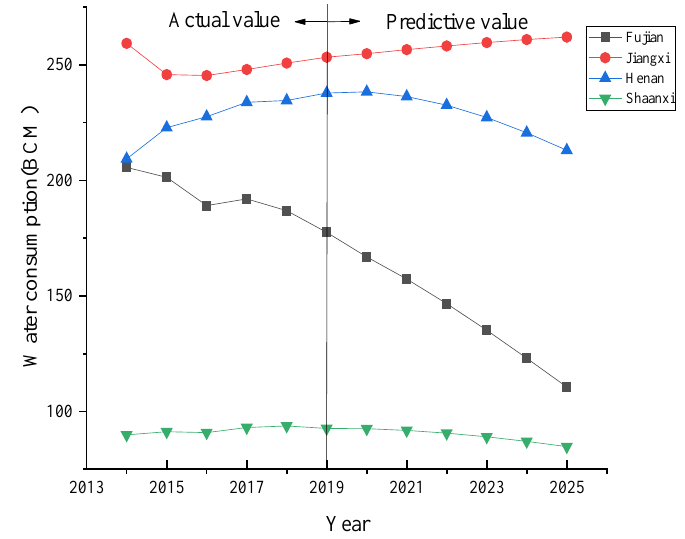
Figure 3. Water consumption in secondary industry dominated regions.